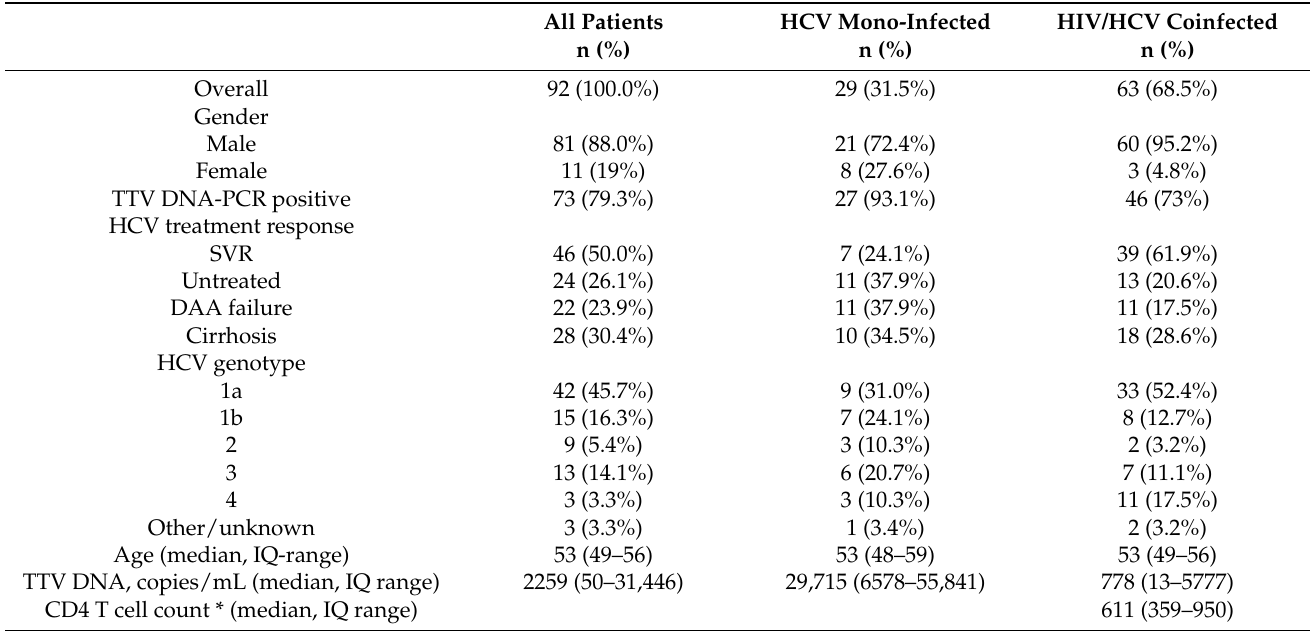
Table 1. General characteristics of the study